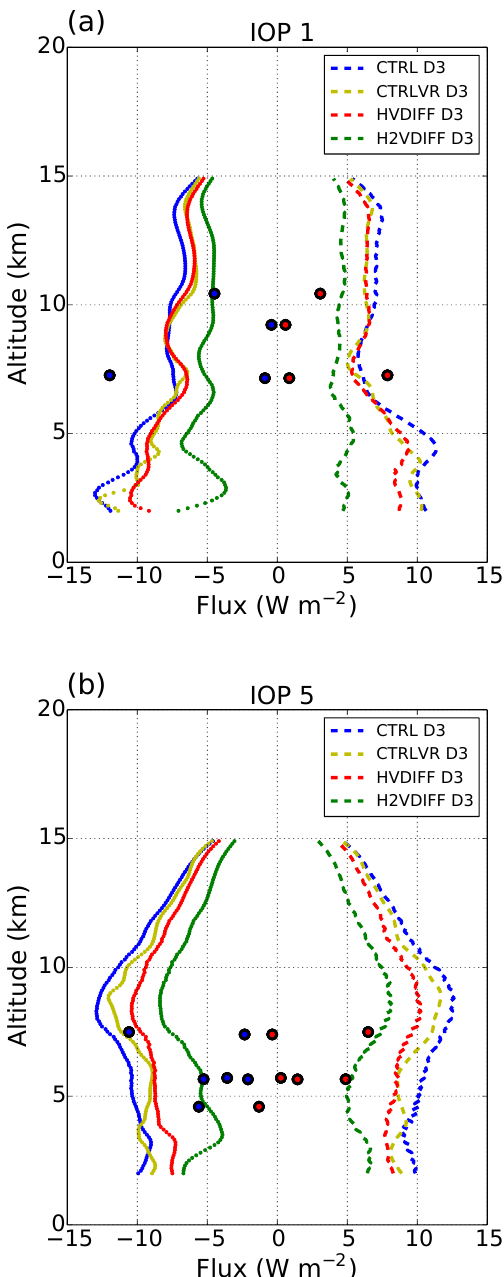
Figure 15. Profiles of EF (dashed lines) and MF (dotted lines) aver- aged over all flight legs during (a) IOP1 and (b) IOP5 for different sensitivity runs of domain D3. Red and blue dots indicate EF and MF obtained from in situ measurements of single flight legs (same as in Fig.